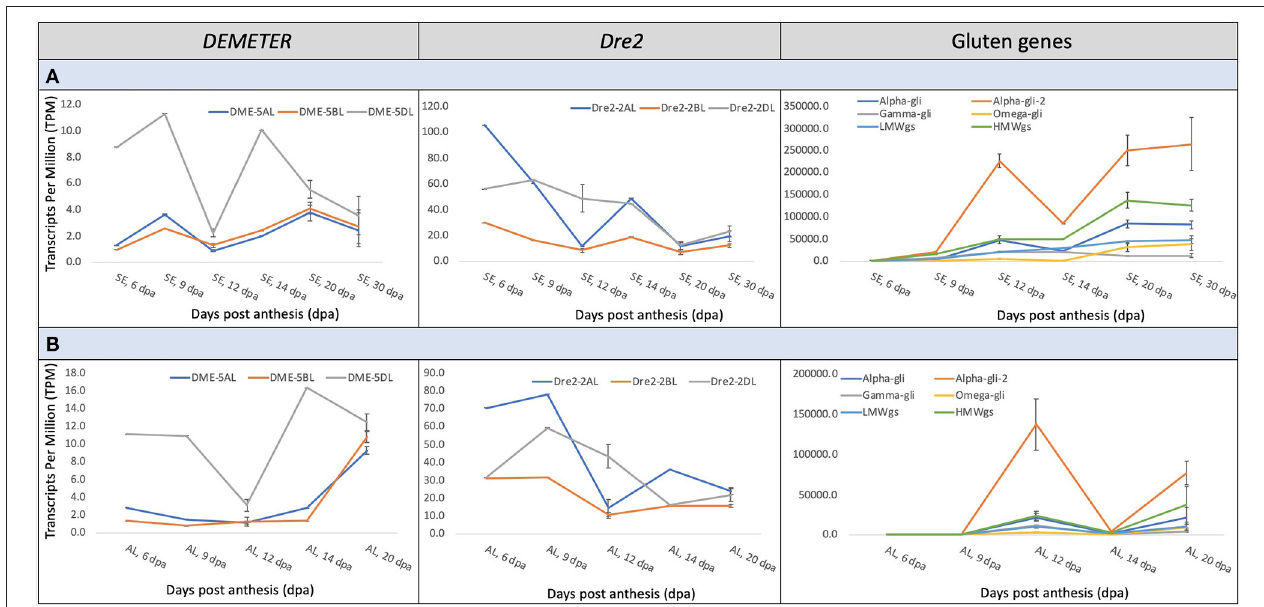
FIGURE 2 | Meta-expression analysis of the wheat DEMETER , DRE2 , and gluten genes at various grain developmental stages from 6–30 days post-anthesis (DPA) in starchy endosperm (A) and 6-20 DPA in the aleurone layer (B) . The data for expression analysis was derived from the Wheat Expression Browser. Notice the differences in the abundance of transcripts of different DEMETER and DRE2 homoeologues and various grain developmental stages and their correspondence with the transcripts of wheat gluten genes.